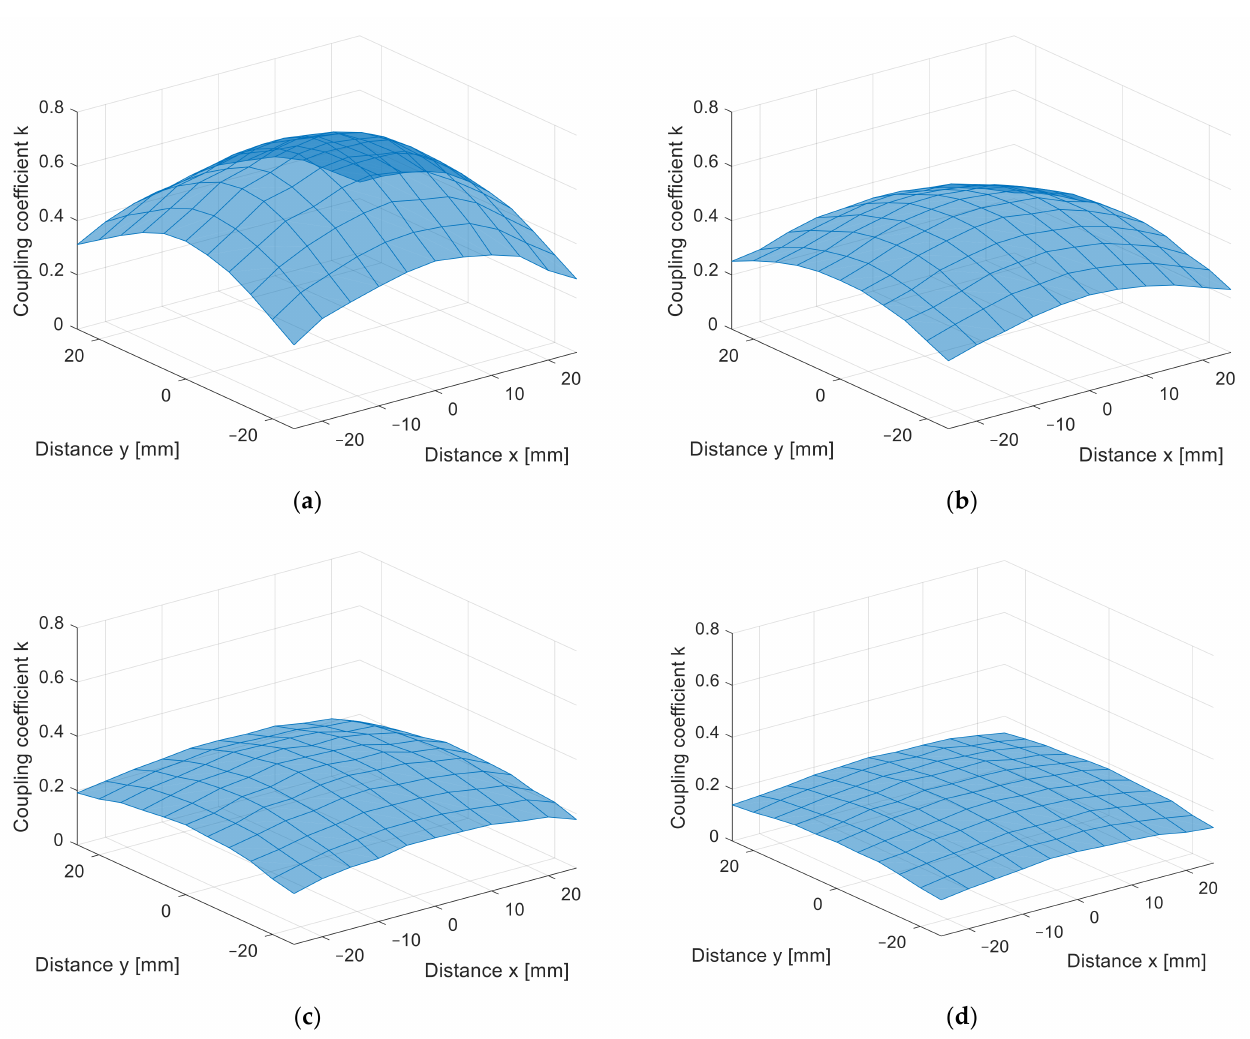
Figure 10. x - y coupling coefficient measurement of planar square coils (3D surface plot). ( a ) At z = 10 mm, ( b ) at z = 15 mm, ( c ) at z = 20 mm, ( d ) at z = 25